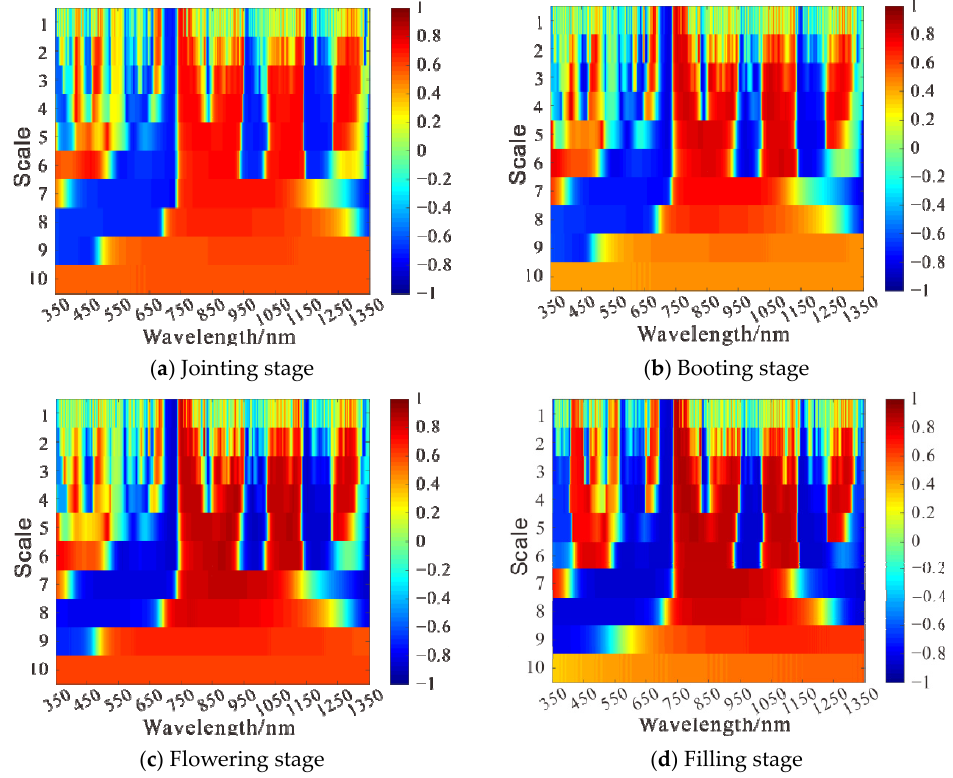
Figure 6. Correlation analysis of wavelet energy coefficient and leaf area index at different growth stages.